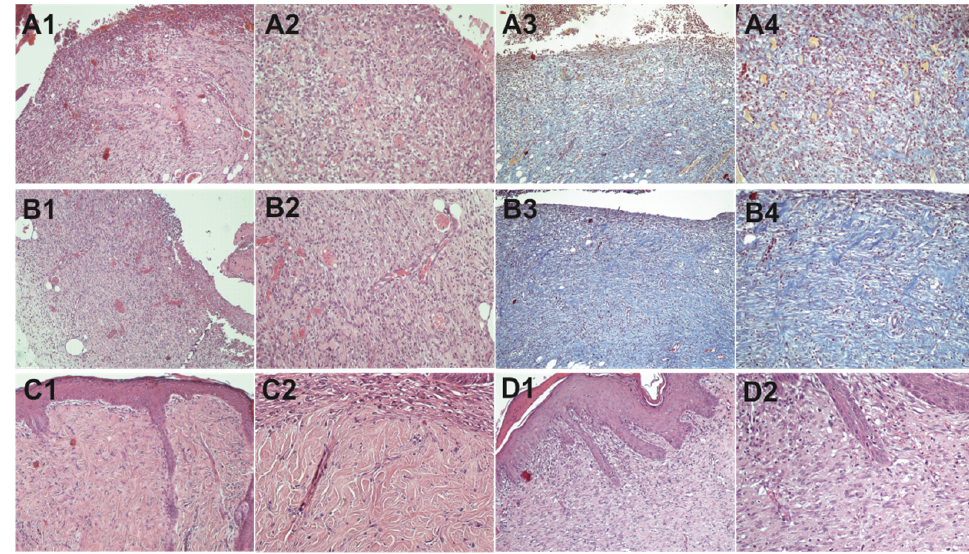
Figure 7. Tissue images of control wounds at day 5 ( A1 – A4 ) and day 10 ( C1 , C2 ) and Urtica dioica L. ointment (2 mg g − 1 )-treated wounds at day 5 ( B1 – B4 ) and day 10 ( D1 , D2 ) at 100× (odd-numbered images) and 200× magnification (even-numbered images). All tissues were stained with hematoxylin and eosin, except for images A3 , A4 , B3 , and B4 , which show tissues stained with Masson’s trichrome.